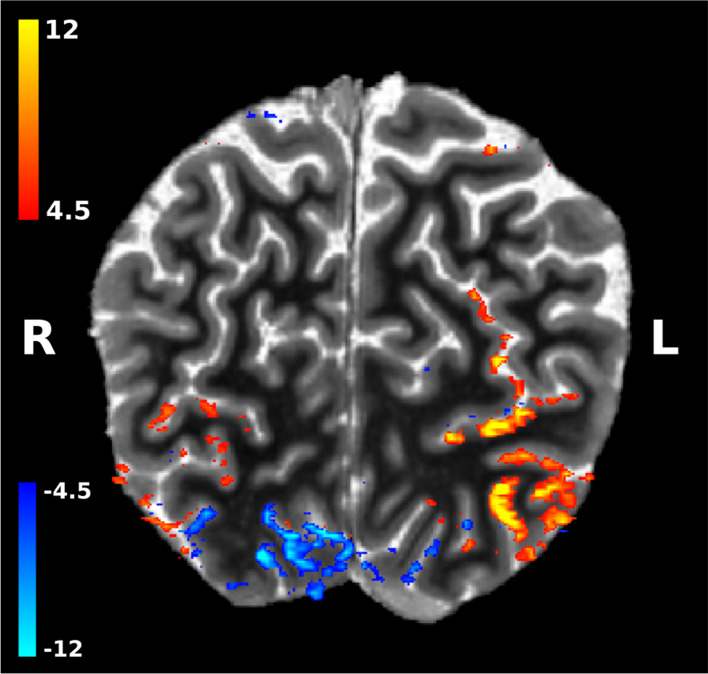
The Pac-Man stimulus caused positive and negative fMRI signal changes across visual cortex.Shown are the z-scores for the GLM contrast Pac-Man dynamic (sustained response) against rest, overlaid on a brain-masked T1 image, for a representative subject. Negative signal changes are particularly pronounced in early visual cortex of the right hemisphere, that is the hemisphere that ‘sees’ the left side of the Pac-Man. (Image is in radiological convention.).